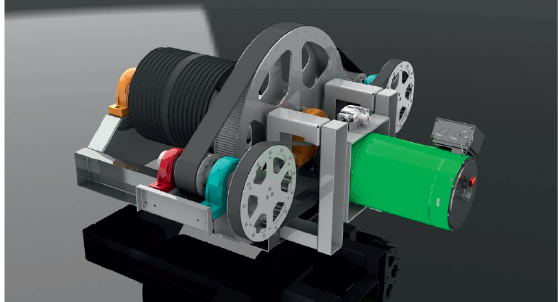
Figure 15. The PTO design based on a belt drive system for the Lifesaver converter [1]. Kindly provided by Jonas